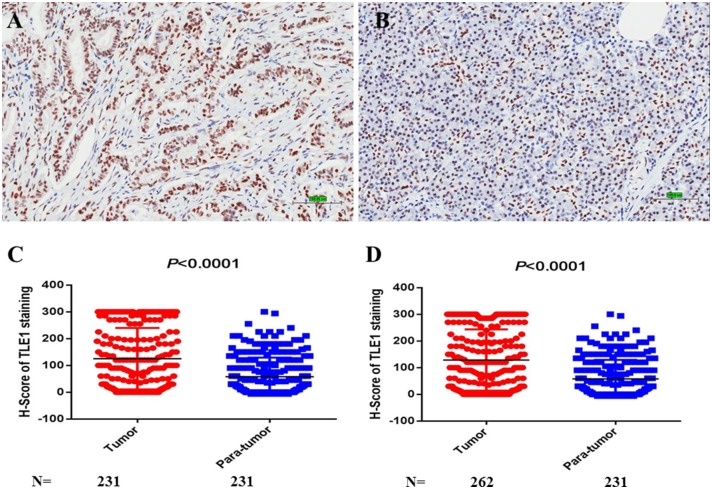
TLE1 expression in pancreatic ductal adenocarcinoma (PDAC). (A) TLE1 expression in tumor tissues (original magnification: 200×; bar, 100 μm). (B) TLE1 expression in para-tumor tissues (original magnification: 200×; bar, 100 μm). (C) Comparison of H-scores for TLE1 expression between tumor and paired para-tumor tissues (P < 0.0001; Mann–Whiney U-test). (D) Comparison of H-scores for TLE1 expression between tumor and non-paired para-tumor tissues (P < 0.0001; Mann–Whiney U-test) (n = 3).